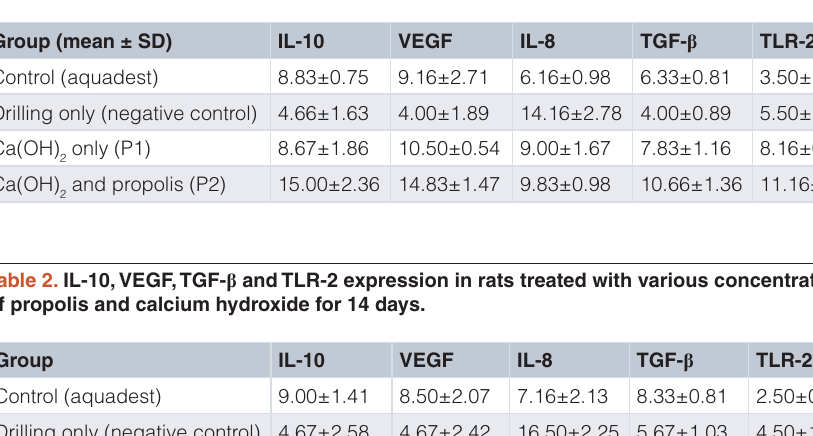
Table 1. IL-10, VEGF, TGF- β and TLR-2 expression in rats treated with various concentrations of propolis and calcium hydroxide for 7 days.